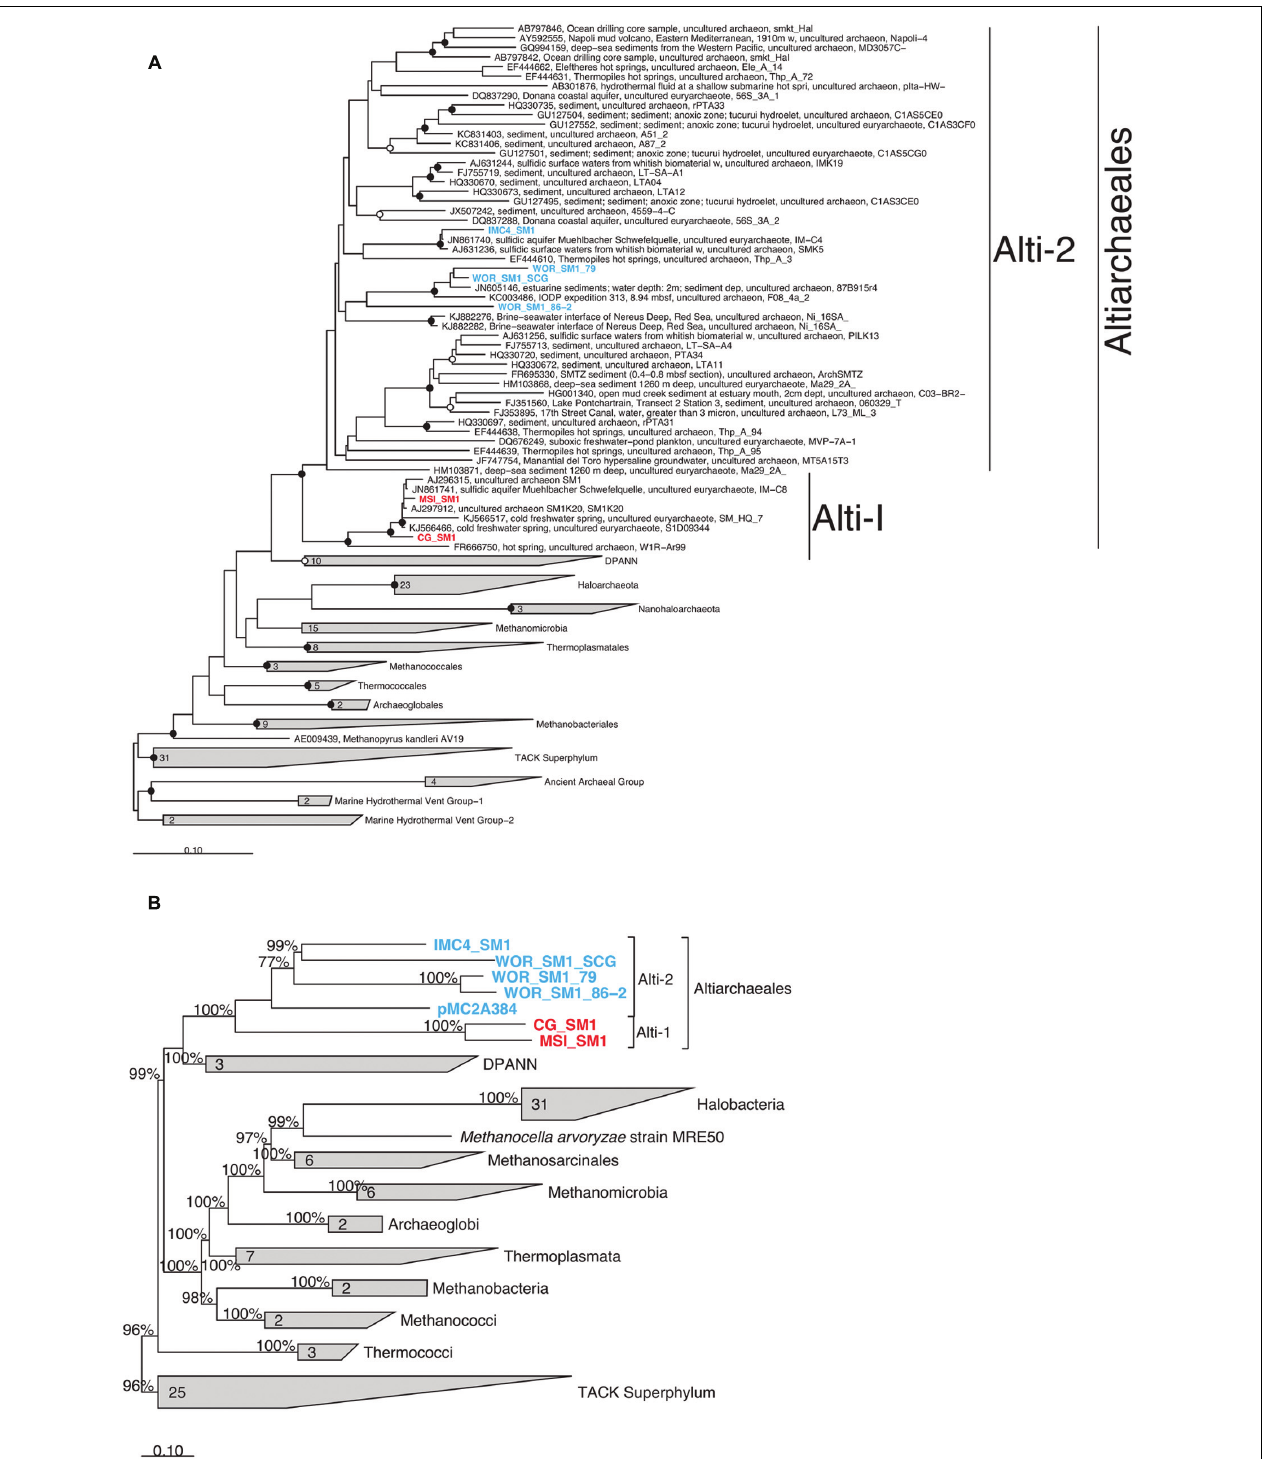
FIGURE 3 | Phylogenetic placement of Altiarchaeales based on (A) a maximum likelihood tree constructed from full length ( > 1300 bp) 16S rRNA gene sequences; smaller sequences ( > 900) within the Altiarchaeales group were added to the tree using maximum parsimony (ARB); filled and open circles indicate bootstrap support at greater than 90 and 70%, respectively, (B) a Phylobayes tree constructed with 10 conserved universal proteins from 94 archaeal genomes. The 2220 amino acid positions which were conserved at 30% across the alignment were compared. pMC2A384 was added via parsimony (ARB). Percentages at nodes indicate proportions of trees which agreed with the displayed branching pattern. Sequences were derived from terrestrial springs (red) and estuarine/lacustrine (blue) samples. Scale bars show 10% difference. Gray trapezoids indicate collapsed clades with the number of individuals